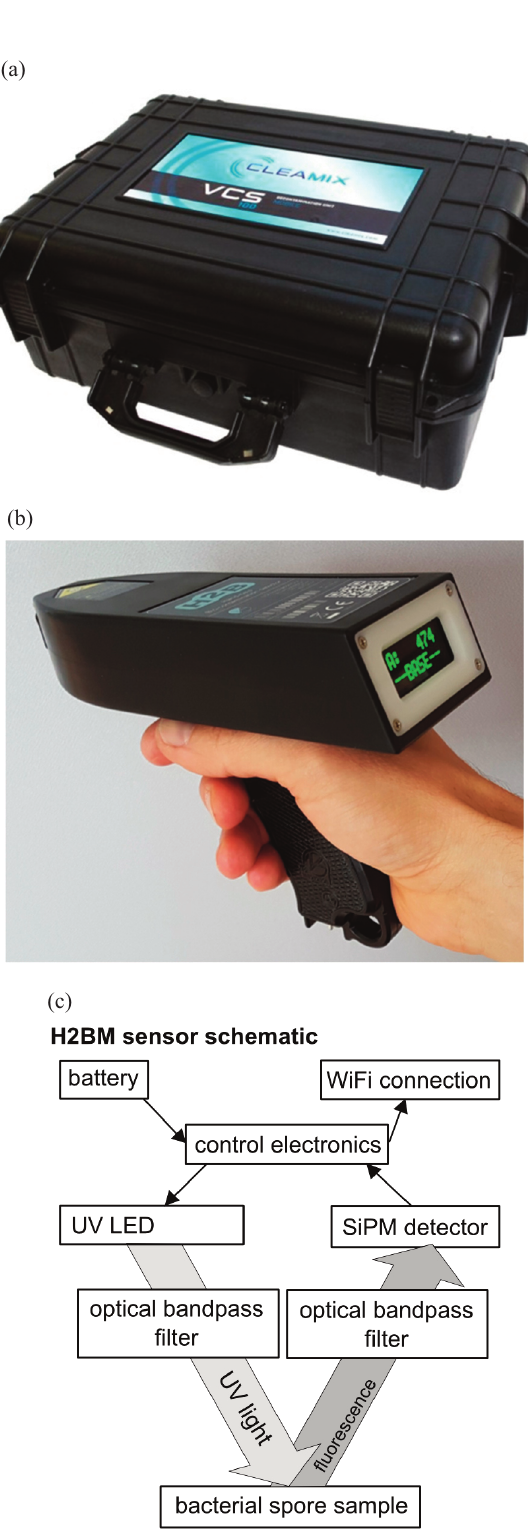
Fig. 1. Main devices used in the research: (a) hydrogen peroxide vapour generation device VCS­100; (b) modified hand­held fluorometer H2BM device for online monitoring of the decontamination process; (c) block scheme of the H2BM device and its operation